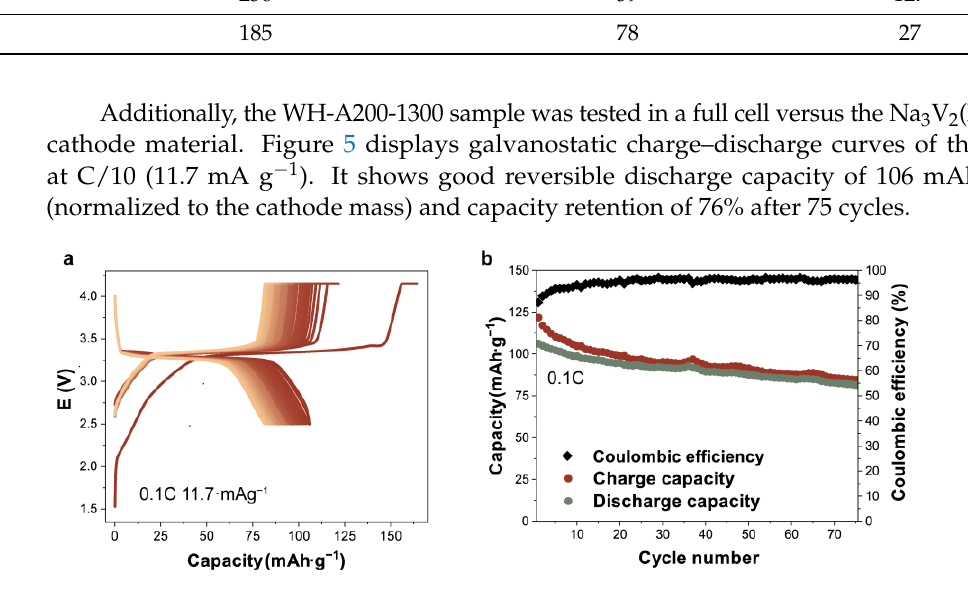
Figure 5. Charge – discharge curves ( a ) and charge – discharge capacity and Coulombic efficiency Figure 5. Charge–discharge curves ( a ) and charge–discharge capacity and Coulombic efficiency during cycling ( b ) of full cell at current density C/10 (11.7 mA g −1 ). during cycling ( b ) of full cell at current density C/10 (11.7 mA g − 1